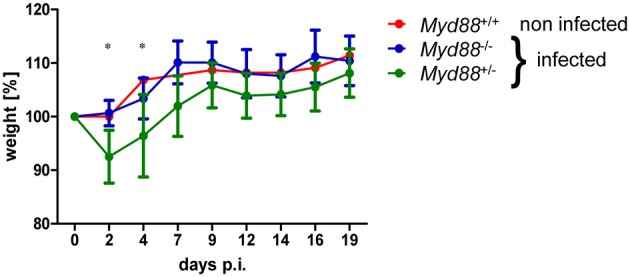
Transient weight loss after NMII infection. Mice were weighed before and at indicated time points after intraperitoneal infection with 5 × 107 NMII. Changes in weight relative to day 0 are shown (mean +/− SD). One non-infected Myd88+/+ mouse was included for comparison. (n = 8 (day 0–5) and n = 4 (day 6–20) for Myd88+/−), n = 7 (day 0–5) and n = 3 (d6–20) for Myd88−/−). Results were analyzed using an unpaired two-tailed Mann-Whitney U test.